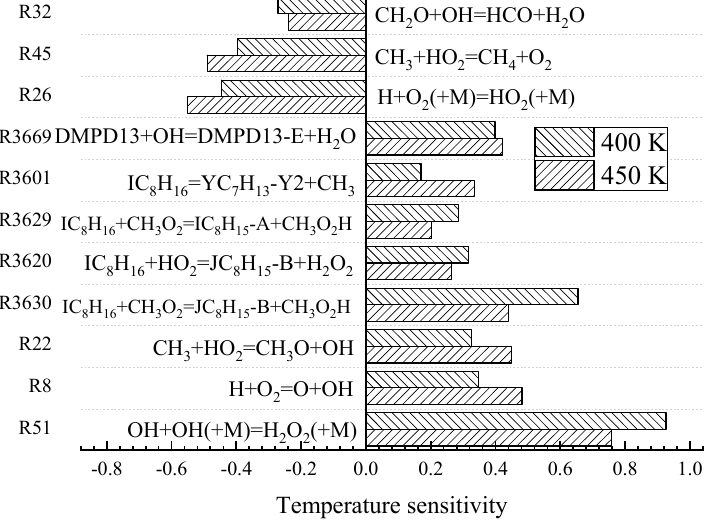
Figure 5. Temperature sensitivity coefficient of engine model simulation for IC 8 H 16 . Pressure 1.5 atm, ϕ = 0.25 and 400 and 450 K.